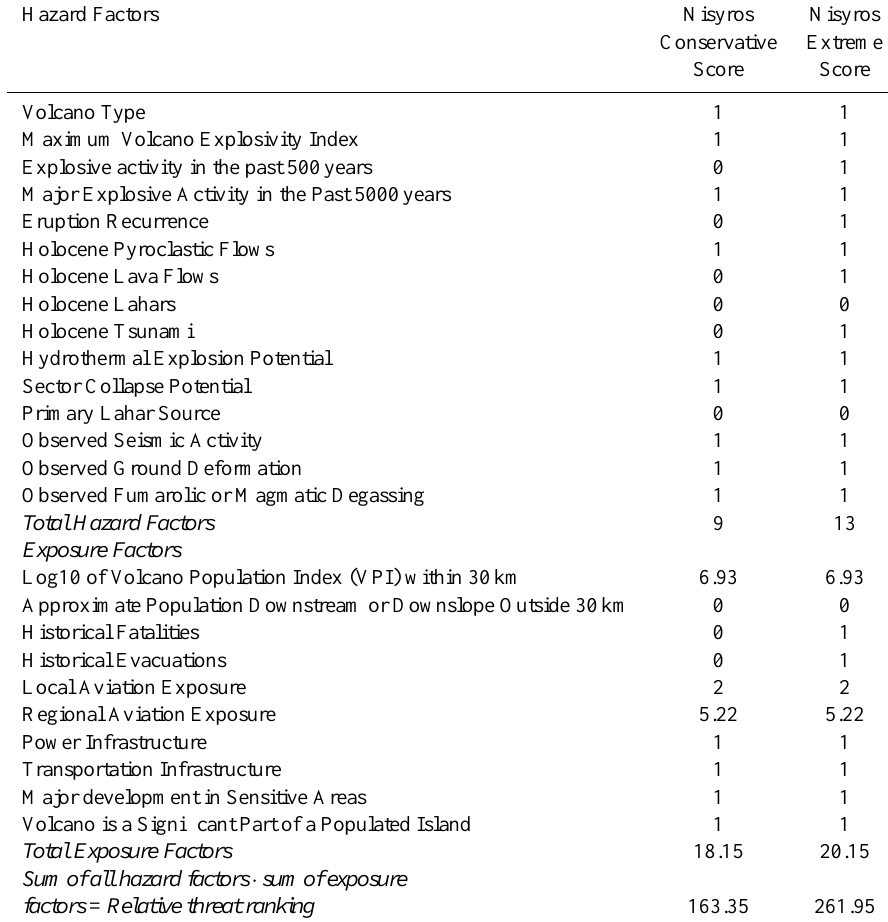
Table 1. List of conservative and extreme threat score for analysis criteria for Nisyros, using the guidelines set out in Ewert (2007). Hazard Factors